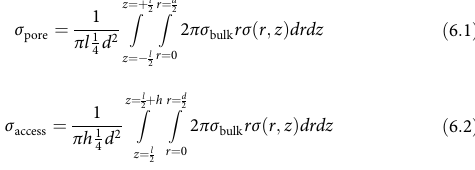
Calculating Stokes radius of NupX and variations . Intrinsically disordered proteins were modelled using the 1BPA model 42,76 , starting from an extended con fi guration. After energy minimization (steepest descent) and a brief (5ns) equilibration step, we simulated the individual proteins for 5× 10 8 steps using a timestep of 20 fs (total simulation time: 10 μ s). Conformations were extracted every 10,000 frames (i.e., every 200 ps). In order to calculate the Stokes radii ( R s ) from the MD trajectories, we extracted protein conformations every 2 ns and applied the HYDRO ++ software 78 in order to calculate the R s values. This procedure yields a total of 5000 Stokes radii per